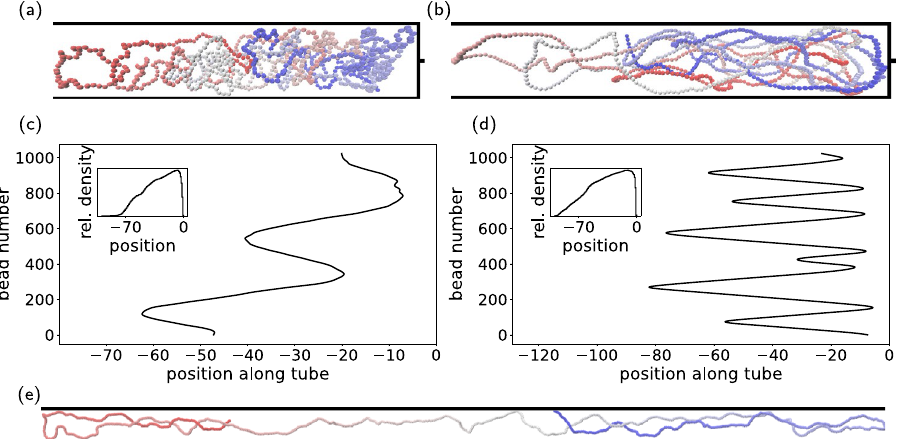
Figure 2. Simulated structures for different parameters. ( a , b ) Structures for κ = 4 ( a ) (length parallel to the channel 73 σ ) and κ = 20 ( b ) (length 91 σ ) visualized using VMD 49 . Beads are colored from blue to red according to their monomer number. ( c , d ) The plots show the average position along the tube for all beads averaged over a simulation time of 50, 000 τ for simulations at κ = 4 ( c ) and κ = 20 ( d ) with the piston at position 0. The insets show the relative density of beads along the structure averaged over the same frames. The structure for κ = 20 is significantly larger. The highest density for both structures is found to be close to the piston on the right. ( e ) Equilibrium structure without piston for κ = 20